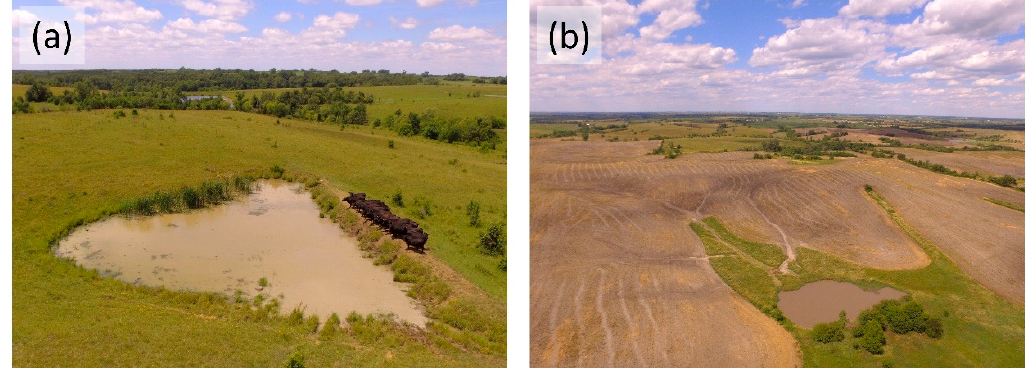
Figure 2. Photographs depicting primary functions of farm ponds in the Eastern Great Plains: ( a ) Ponds play a vital role in supporting cattle production by providing a reliable water source for livestock. ( b ) Ponds located on row crop fields are used to mitigate soil erosion by capturing sediment- laden runoff.